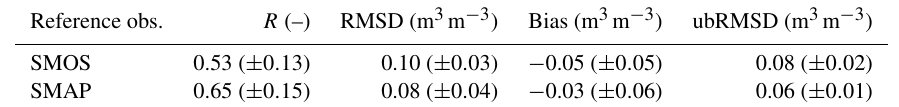
Table 3. Spatial mean ( ± spatial standard deviation) of R , RMSD, bias, and ubRMSD between SIM1 SSM estimates, SMOS, and SMAP, for April 2015 through December 2016. Reference obs.